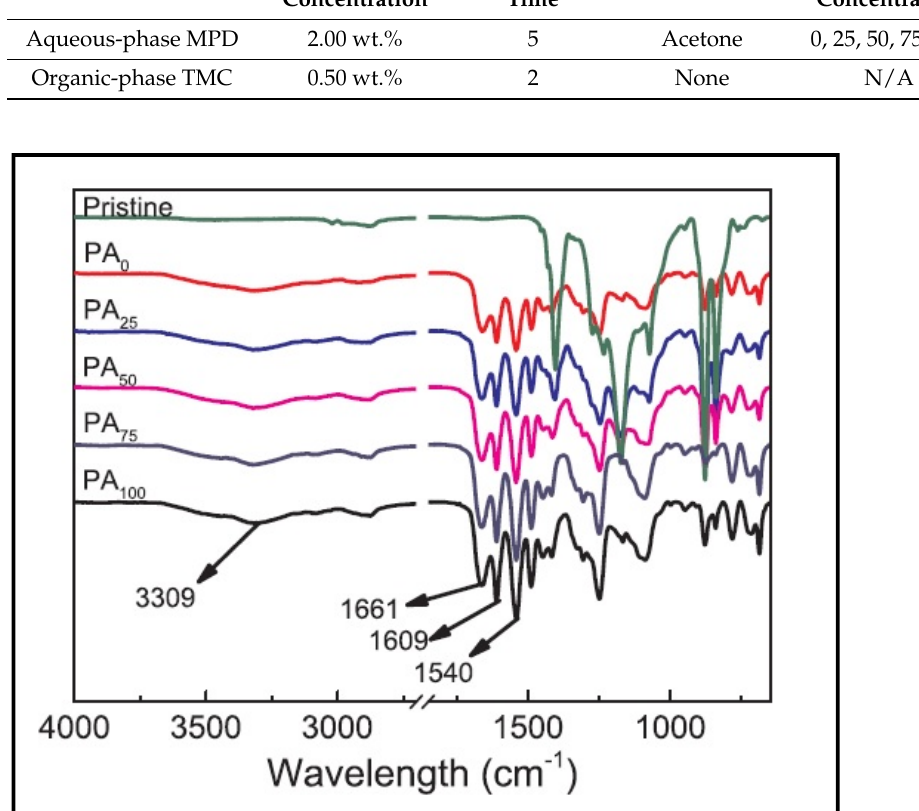
Figure 8. ATR-FTIR spectra of polyvinylidene fluoride (PVDF) and polyamide membranes by using different concentrations of acetone in aqueous phase through interfacial polymerization. Reprinted with permission from ref. [43]. © 2018 Elsevier B.V.